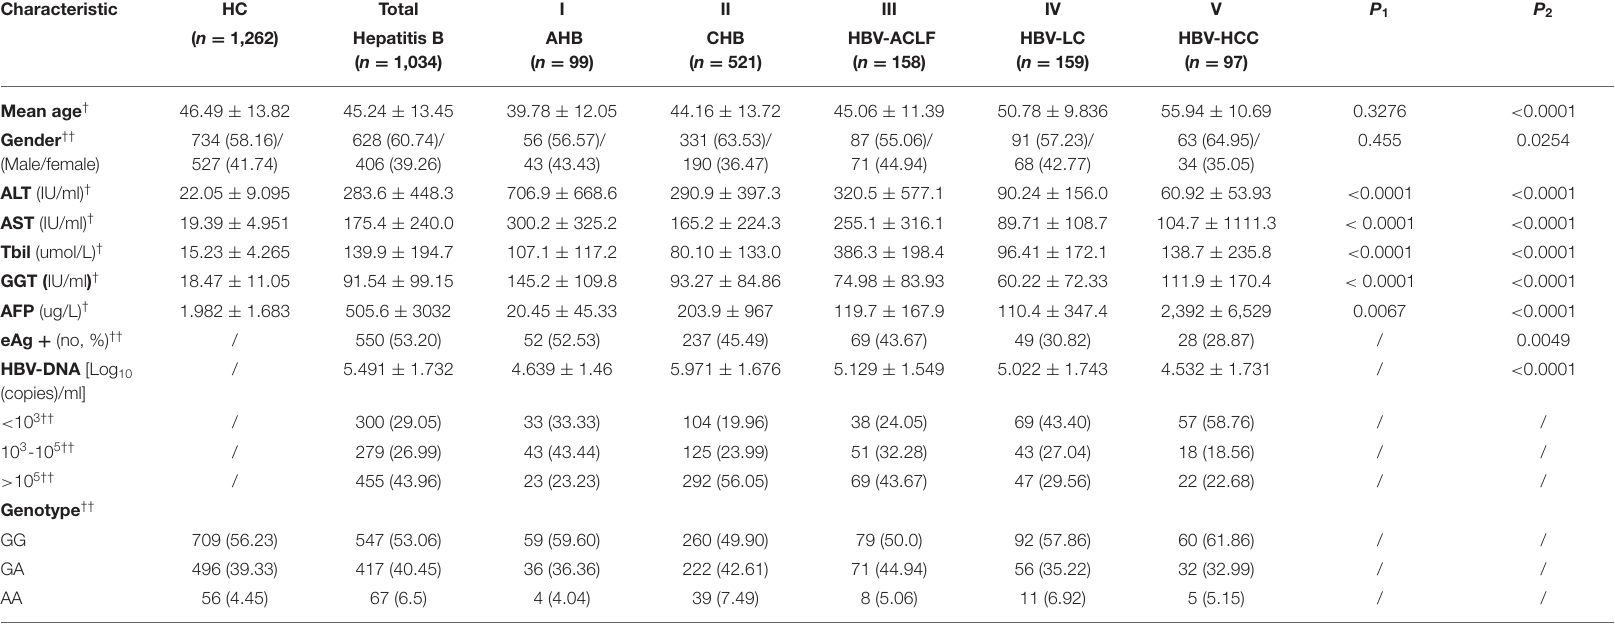
TABLE 1 | Demographic and clinical features of the patients and healthy controls in the study.